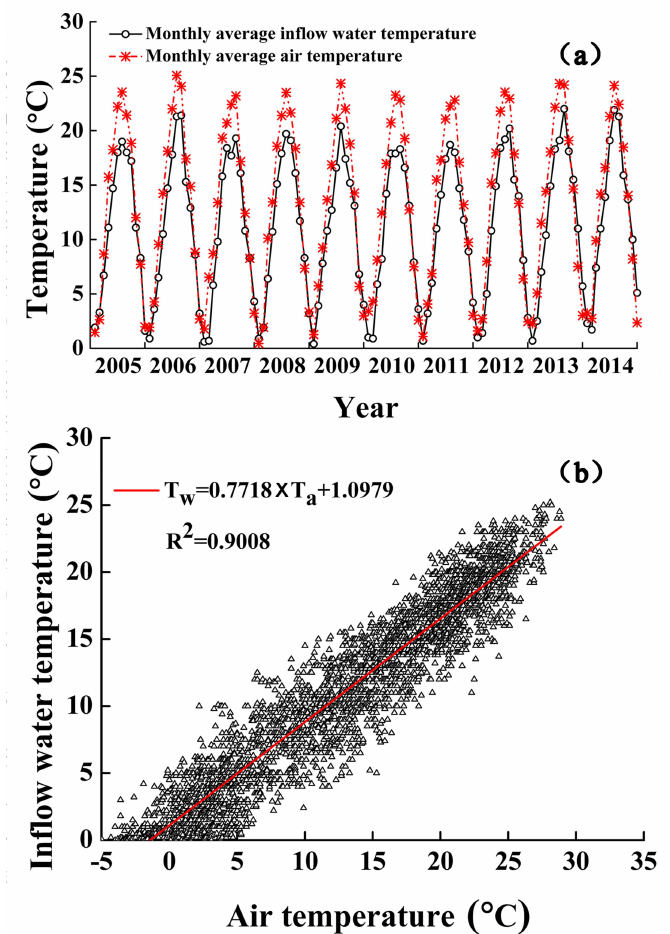
Figure 4. ( a ) The variation in monthly average inflow water temperature and monthly average air temperature and ( b ) the relationship between air temperature and inflow water temperature, both from 2005 to